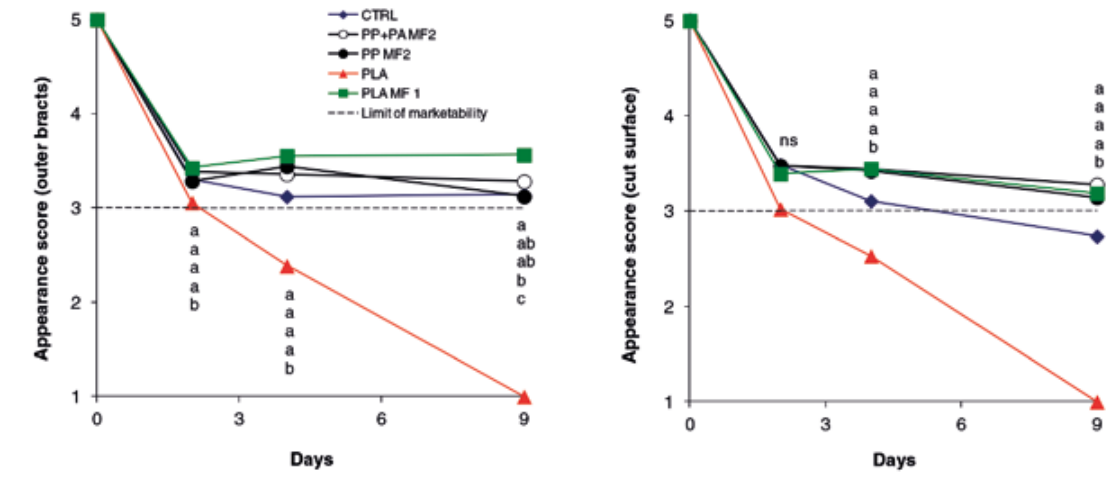
Fig. 2 - Changes over time of overall appearance in fresh-cut artichoke quarters packaged in active modified atmosphere (5% O stored at 4°C: PP+PAMF2= polypropylene + polyamide with two lines of micro-perforations; PP MF2= polypropilene with two lines of micro-perforations; PLA MF1= polylactid acid with one line of micro-perforation; PLA= polylactic acid without micro-perforation. CTRL represents samples stored in air in macro-perforated bags. At each storage sampling different letters indicate significant differences